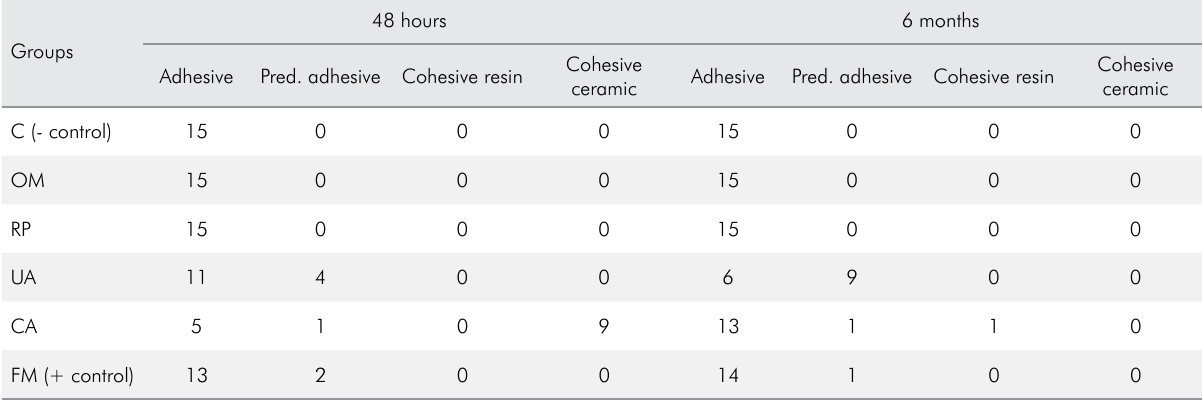
Table 2. Failure modes of each surface treatment after 48 hours and 6 months of storage. Groups